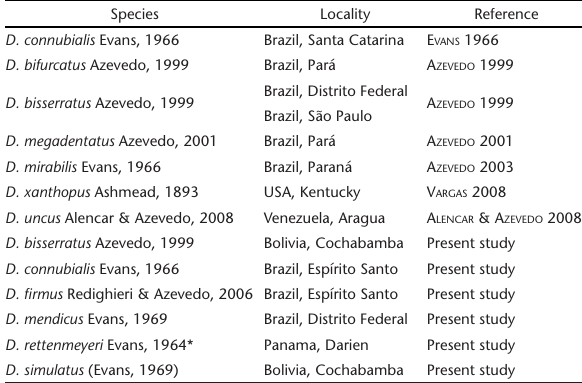
Table 1. Species of Dissomphalus with female and male associated by phoretic copulation (in chronological